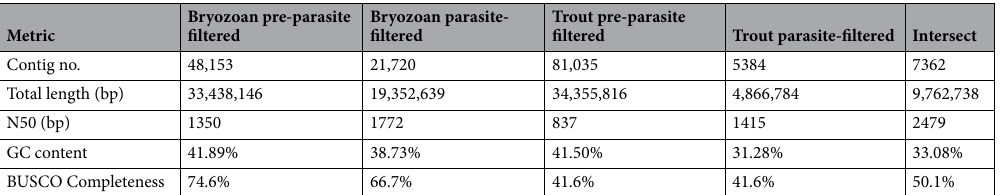
Table 1. Assembly statistics for sequenced transcriptome datasets pre- and post-parasite filtering with T. bryosalmonae genome sequence